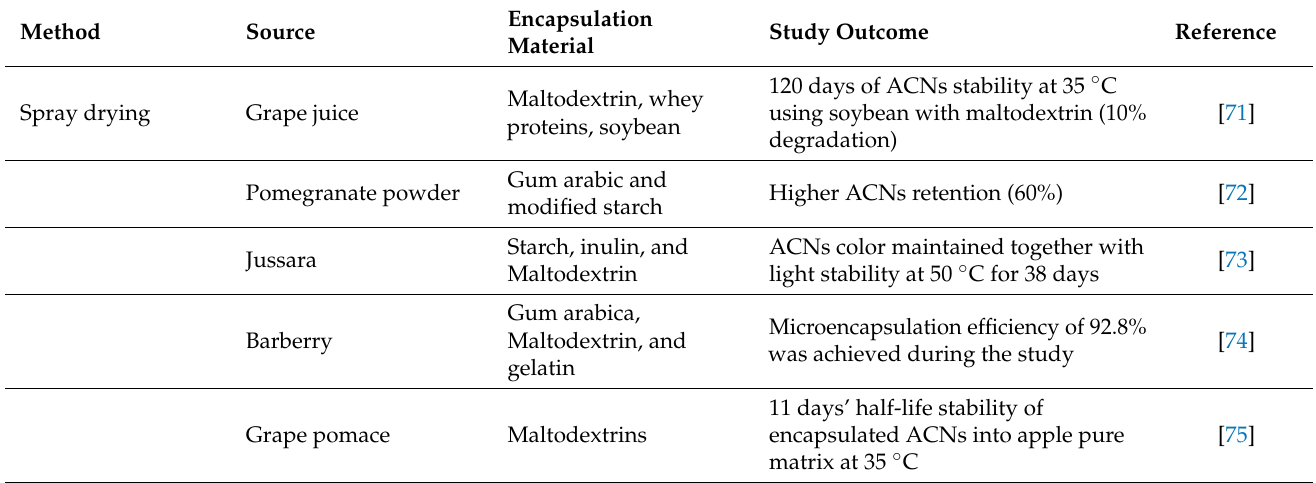
Table 1. Methods for encapsulation of anthocyanin using different material and their